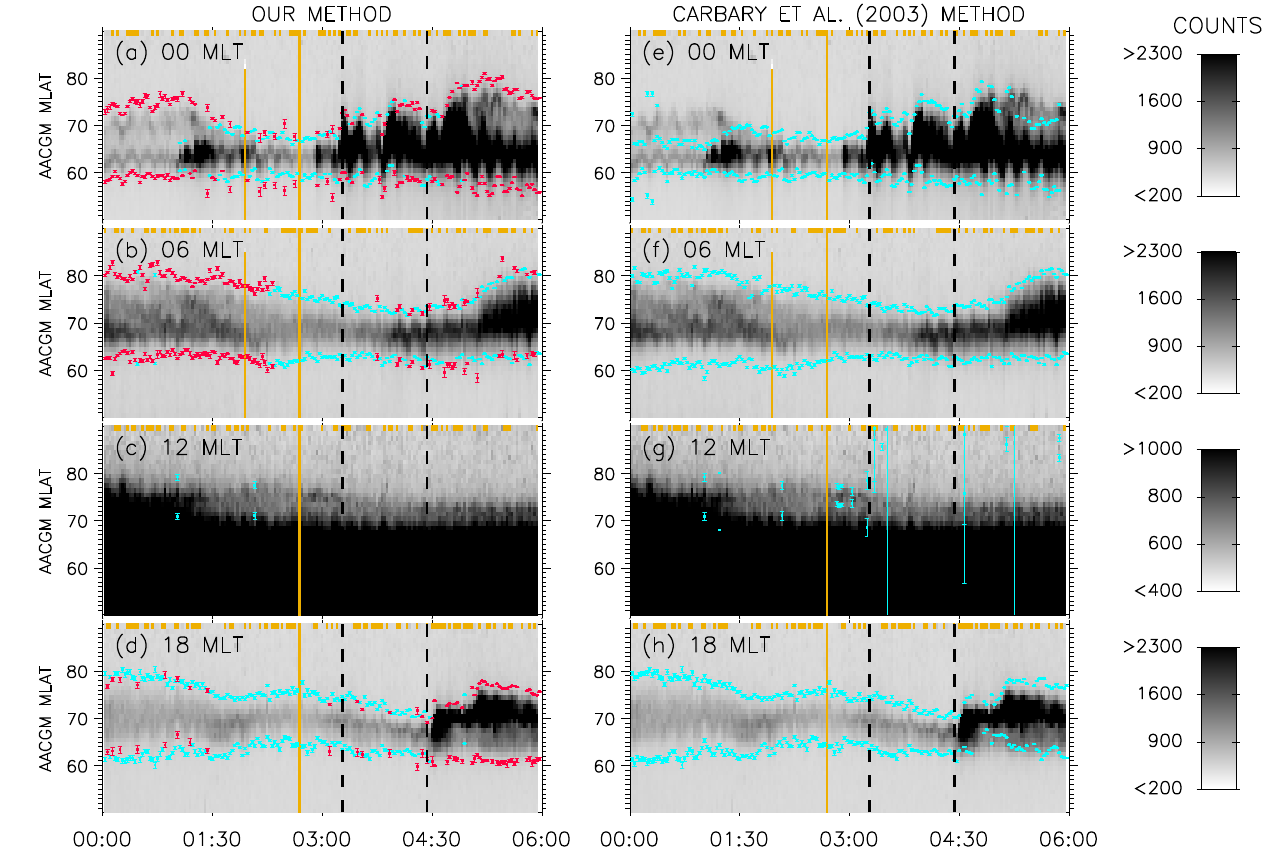
Fig. 2. Intensity counts recorded by the IMAGE FUV WIC sensor on the 1 February 2001 between 00:00 and 06:00UT. Count values above and below thresholds indicated in the intensity scales have been saturated. Not a Number (NaN) and zero count intensity values are shown in yellow. From top to bottom, the panels show the MLT sectors 00:00–01:00, 06:00–07:00, 12:00–13:00, and 18:00–19:00, respectively. Panels (a) to (d) show auroral luminosity boundary locations derived according to the method detailed in this paper. Blue squares denote poleward and equatorward luminosity boundaries determined from fits to a function with a single Gaussian component ( F s (λ) ), with blue error bars showing ± U λ on these boundaries. Red squares denote poleward and equatorward luminosity boundaries determined from fits to a function with a double Gaussian component ( F d (λ) ), with red error bars showing ± U λ on these boundaries. Panels e to h show these data with auroral luminosity boundary locations derived according to the method detailed in Carbary et al. (2003). Vertical dashed black lines indicate times of substorm onset from the list outlined in Frey et al.